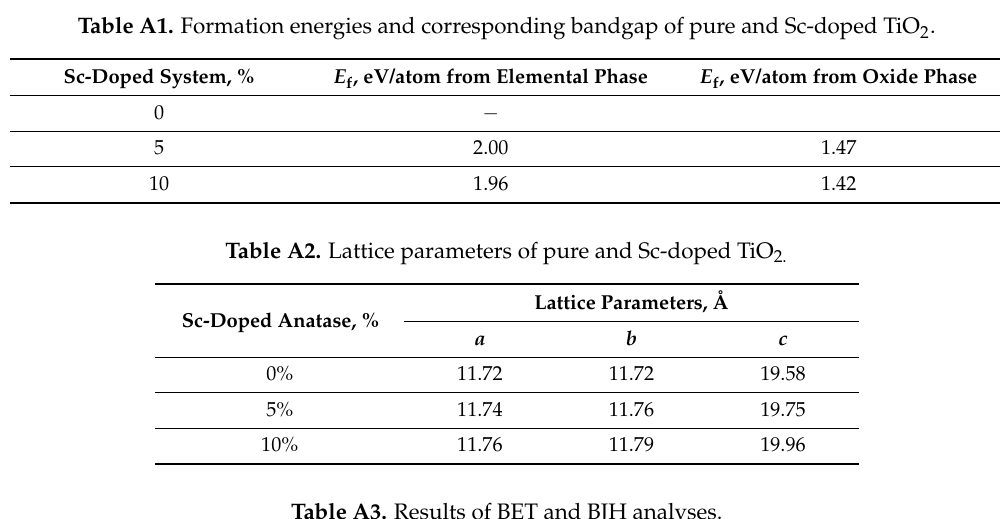
Table A3. Results of BET and BJH